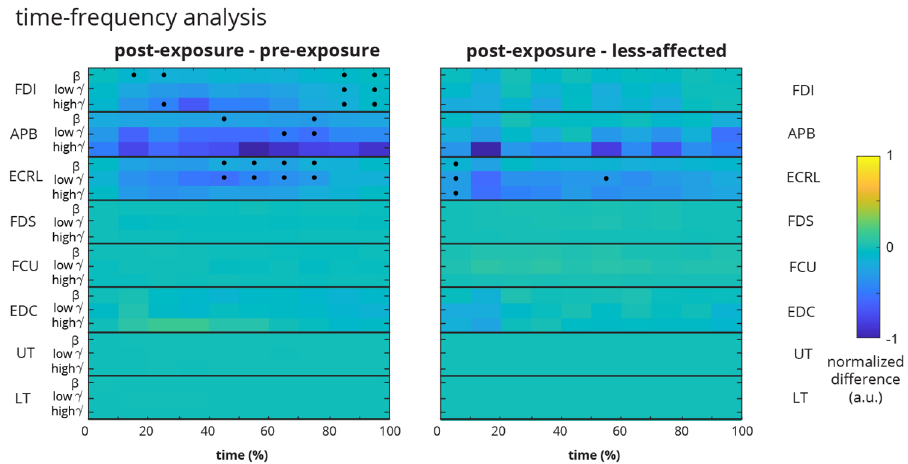
Figure 4. Time-frequency comparison of sEMG using STFT. ( Left ) The comparison of sEMG spectral power between pre-exposure and post-exposure affected limbs shows that FDI, APB, and ECRL muscles have overall decreases in spectral power during portions of the trials. ( Right ) The comparison of sEMG spectral power between post-exposure affected and less-affected limbs does not show significant spectral changes except for ECRL. The color of the boxes indicates the difference between the respective limbs normalized to the absolute maximum difference in each grid. Dots indicate a significant difference after accounting for multiple